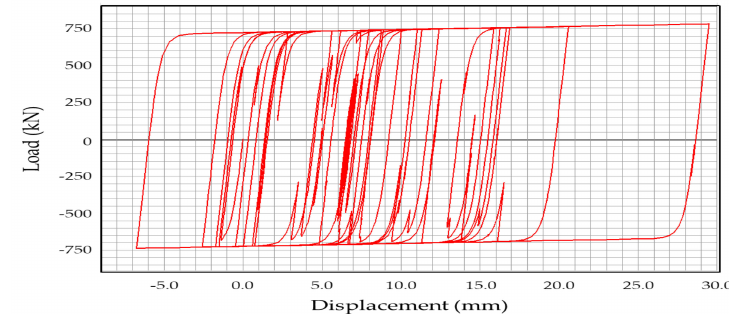
Figure 16. Force-displacement hysteresis curve of R-FBI in P3 at PGA 0.154 g.